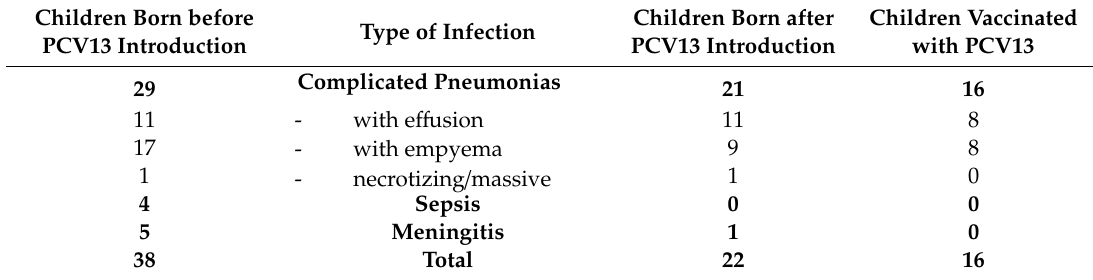
Table 2. Number of cases grouped for infection type in children under 8 years of age with